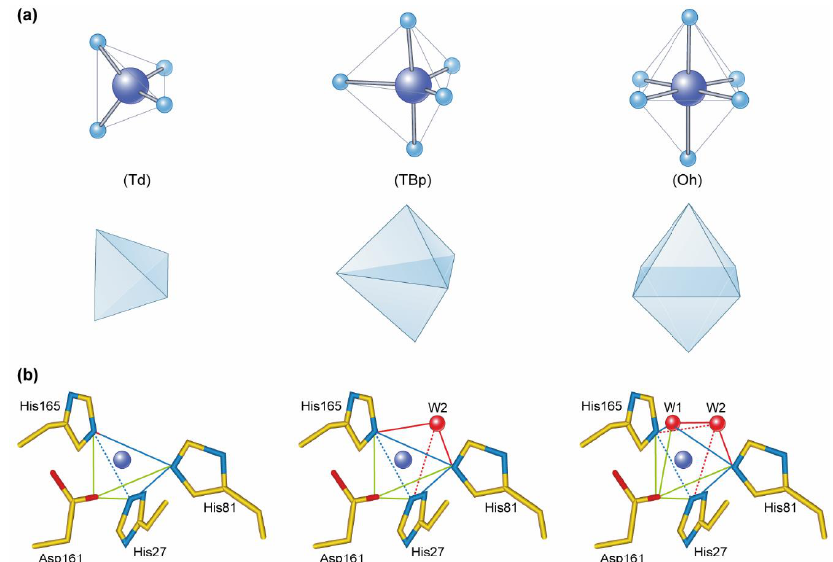
Figure 1. ( a ) The three dominating coordination geometries and coordination numbers observed in Mn (purple sphere) containing metalloproteins are tetrahedral (Td, n = 4); trigonal bipyramidal (TBp, n = 5) and octahedral (Oh, n = 6). ( b ) The active site of Mn-SOD in the presence of Mn (purple sphere), with and without water molecules (W1 and W2, red spheres) in the coordinating sphere. Three His residues (His 165, 27, and 81), one Asp (161) coordinates Mn, and the involvement of 0, 1, or 2 water molecules determines the geometry of the Mn complex at the active site. Zero water produces Td, binding of W1 yields TBp, and binding of W1 and W2 produces the Oh geometry. It has been speculated that the geometry of the active sites changes during scavenging of reactive oxygen species [21] . Table 1. Chemical properties of selected divalent metal ions. The second ionization potential (eV) has proven to be a useful proxy for the polarizability of biologically relevant metal ions. The ionic radii are adapted from Irving and Williams [23] and all other values are adapted from Andreini et al. [24]. According to the hard and soft acids and bases (HSAB) classification, the metal ions (Lewis acids) are divided into hard (H), borderline (B), or hard-borderline (HB) types. The most common coordination geometries are abbreviated as follows: T d , tetrahedral; O h , octahedral; D 3h , trigonal bipyramidal; D 4h , square planar; C 4v , square pyramidal; IR, irregular.